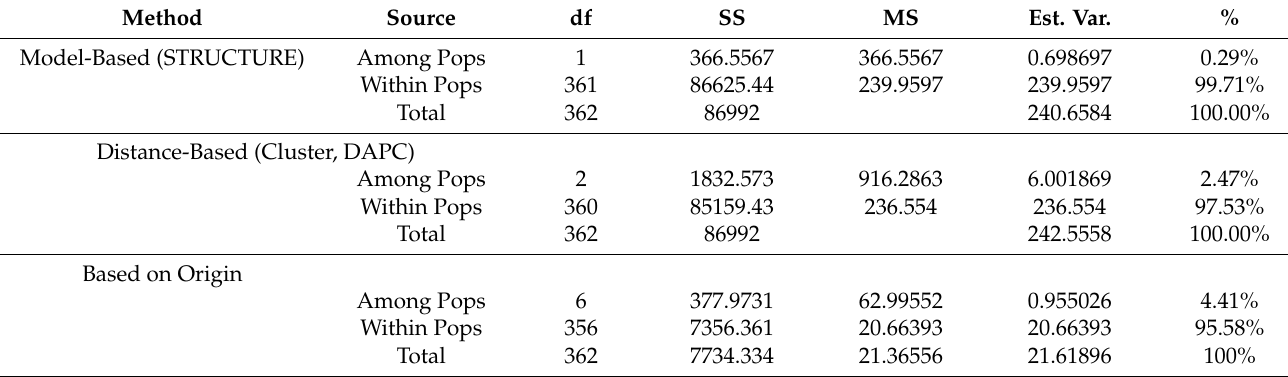
Table 3. Analysis of molecular variance (AMOVA) revealing genetic diversity in the Afghan landraces. Method